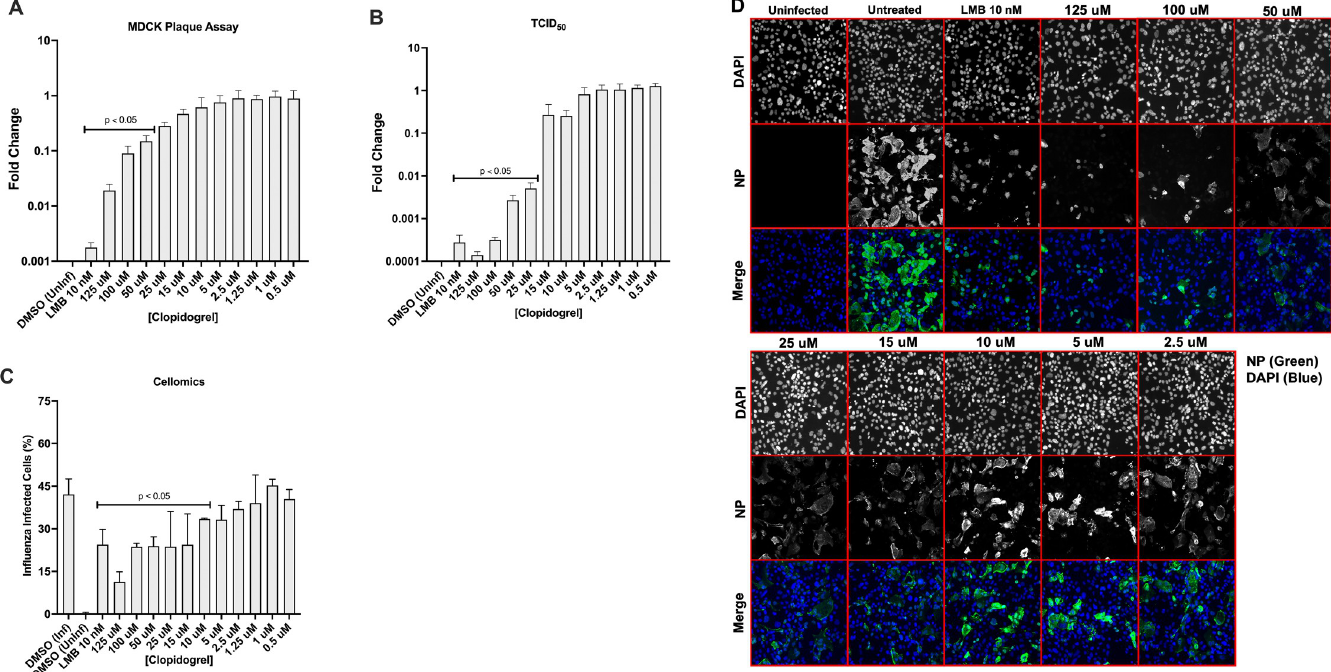
Fig 2. Pretreatment with Clopidogrel reduces A/WSN/33 replication. Calu-3 cells were treated with Clopidogrel for 24h or LMB for 2h before infection with A/WSN/ 33 (MOI = 0.01). At the time of infection, the media was removed and the virus was added with drug replenishment. The infection was incubated for 24h. Post- infection, supernatants were collected and evaluated by plaque assay (A) and TCID 50 HA endpoint assay (B). Fixed Calu-3 cells were immunostained for NP and DAPI for Cellomics analysis (C) and imaging (D). Data show means ± standard errors of the means for two independent experiments performed in triplicate. Statistically significant differences from DMSO-treated controls were determined by one-way analysis of variance with Dunnett’s multiple-comparison test (p < 0.05) and are indicated on graphs where appropriate. Influenza NP is green; nuclei are blue.